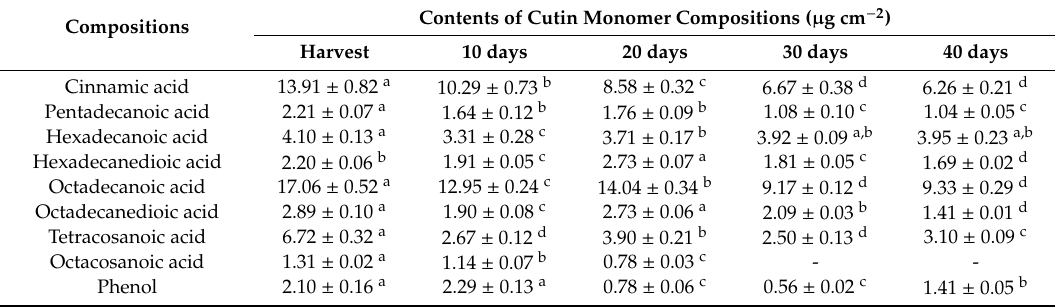
Table 4. Cutin monomer compositions of the ‘Satsuma’ mandarin fruits during storage.